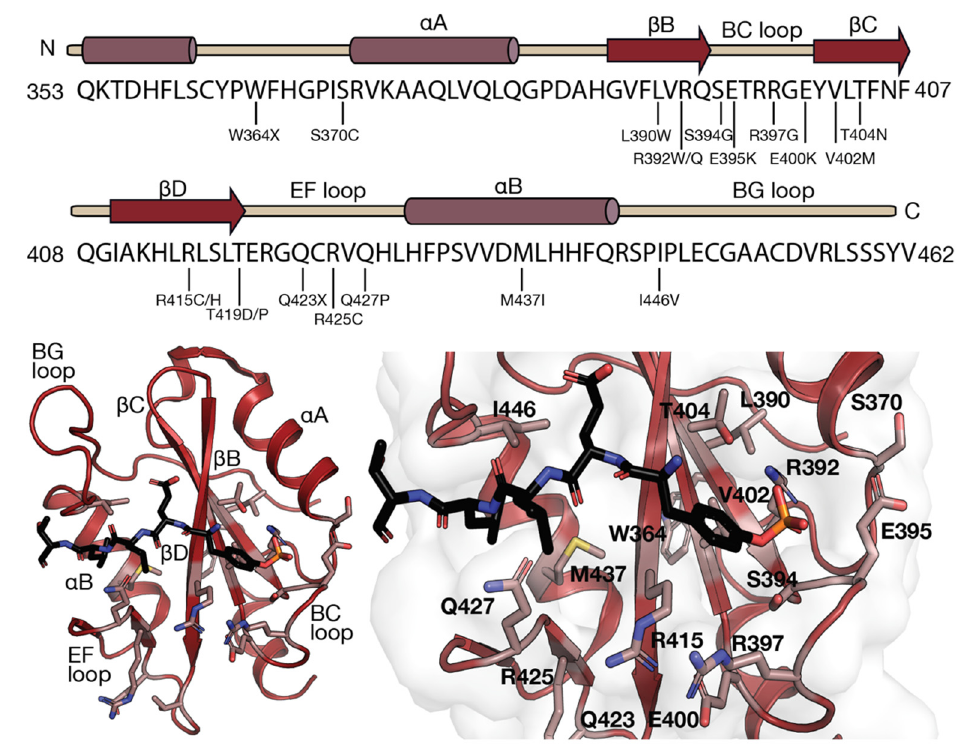
Figure 3. Mutations located within the LNK SH2 domain. Secondary structural elements of the LNK SH2 domain with the position of mutations identified within the SH2 domain indicated ( top ). Structure of the M. musculus LNK SH2 domain with the JAK2 pY813 peptide bound (PDB ID: 7R8W). Residues identified as mutation sites are shown as sticks and highlighted in pink ( H. sapiens LNK SH2 domain numbers are indicated, all residues are conserved in M. musculus ).